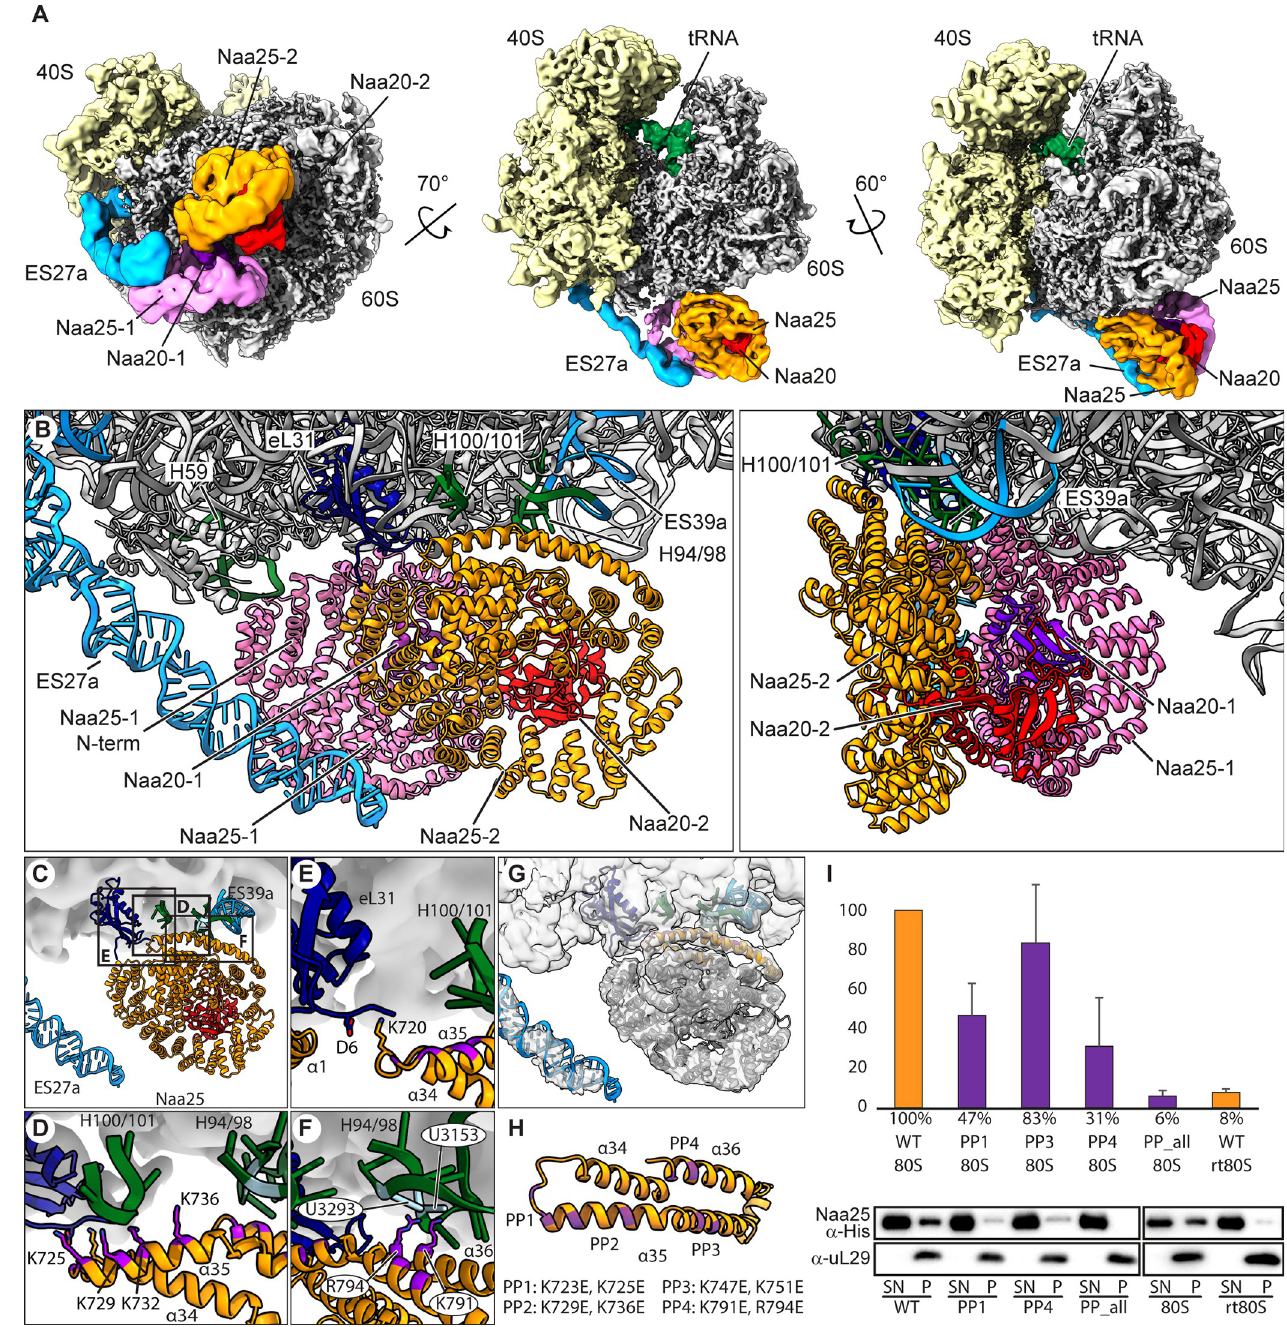
Fig 2. Cryo-EM structure and model of the NatB-ribosome complex. ( A ) Composite map showing cryo-EM structures of NatB in complex with translating 80S ribosomes (RNC MDEl ) filtered according to local resolution. Isolated densities of NatB-1 (from class I) and NatB-2 (from class II) were extracted after the final refinement. Views are shown on the peptide tunnel exit (left; bottom view), rotated 70˚ horizontally (middle; front view), and rotated 60˚ vertically (right; side view). ( B ) Zoom on the peptide exit site showing the NatB-ribosome molecular model (NatB-1 and NatB-2) in front (left) and side views (right) as indicated in ( A ). Overview (upper left panel ( C )) and zoomed views ( D - F ) focusing on the Naa25-2 ribosome contact sites. Interactions of ( D ) helix α 35 at the C-terminus of Naa25-2 with the H100/101-and H94/98 junctions, ( E ) the Naa25-2 α 34- α 35 loop (Lys720) with Asp6 in the N-terminus of eL31, and ( F ) Lys791 and Arg794 at the very C-terminus ( α 36) of Naa25-2 with U3153 and U3293 within H94/98-junction are shown. NatB-1 was omitted for clarity. ( G ) Same view as ( C ) showing the model for the NatB-2 ribosome complex docked in density and highlighting Naa25-2 C-terminus (orange). ( H ) Model of the Naa25 C- terminus highlighting the position of the four positive patches (PPs). All patches contain two charged amino acids as indicated. Charge inversion double mutants were generated (PP1, PP3, PP4, and PPall). ( I ) Western blot analysis of sedimentation assays (triplicates) using recombinant wild-type or mutant NatB